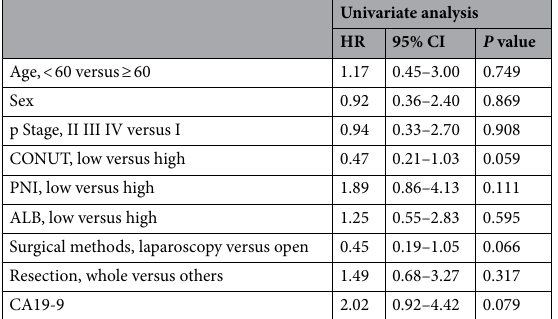
Table 9. Logistic regression analysis of independent risk factors for T-AI.